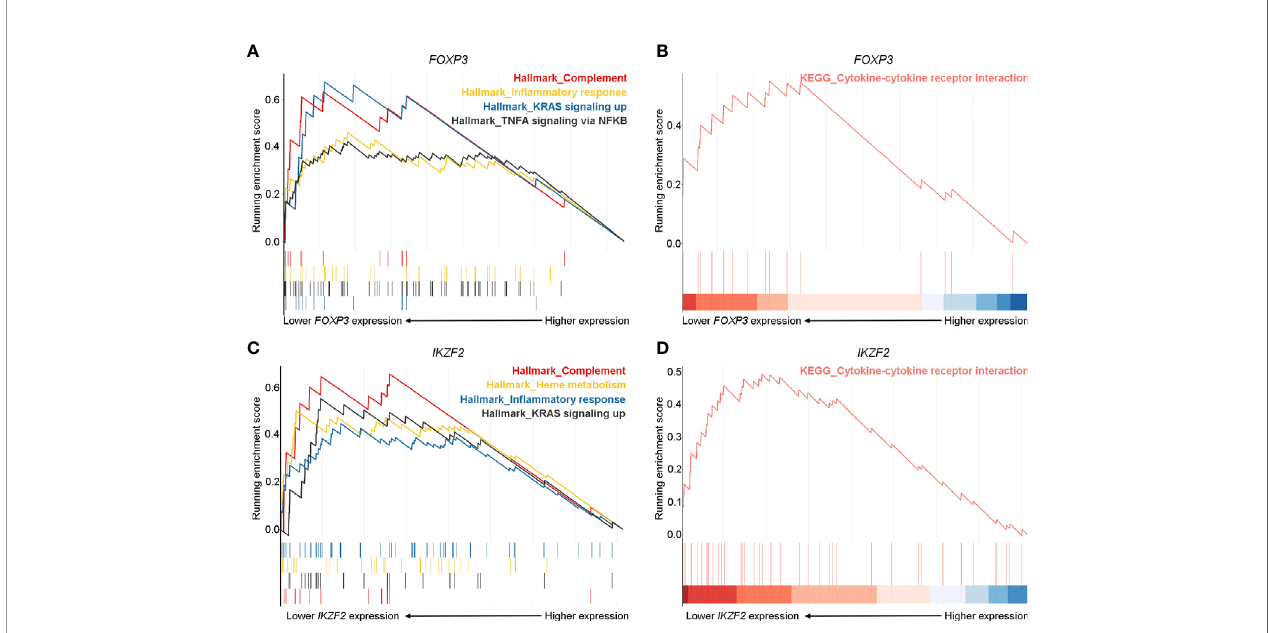
FIGURE 5 | Robust in fl ammatory and cytokine responses pathways were prominent in pGD patients with lower FOXP3 and IKZF2 expression. (A, C) Gene set enrichment analysis (GSEA) showed complement, in fl ammatory response, KRAS signaling up pathways in hallmark gene set were most enriched in pGD patients with (A) lower FOXP3 and (C) lower IKZF2 expression. (B, D) GSEA showed cytokine-cytokine receptor interaction pathway in Kyoto Encyclopedia of Genes and Genomes (KEGG) pathways was obviously enriched in pGD patients with (B) lower FOXP3 and (D) lower IKZF2 expression. pGD, persistent Graves ’ disease.